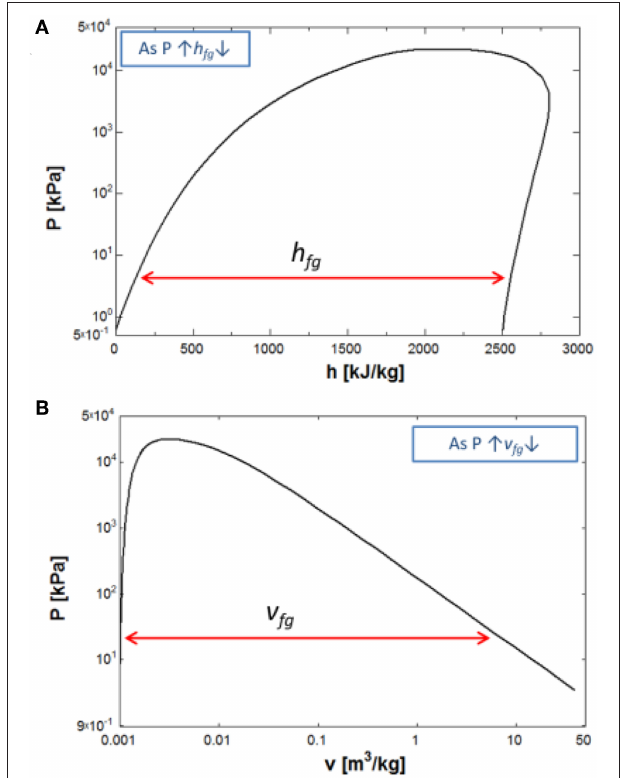
FIGURE 1 | The effect of pressure on the thermophysical properties of water. (A) The latent heat of vaporization. (B) The specific volume of